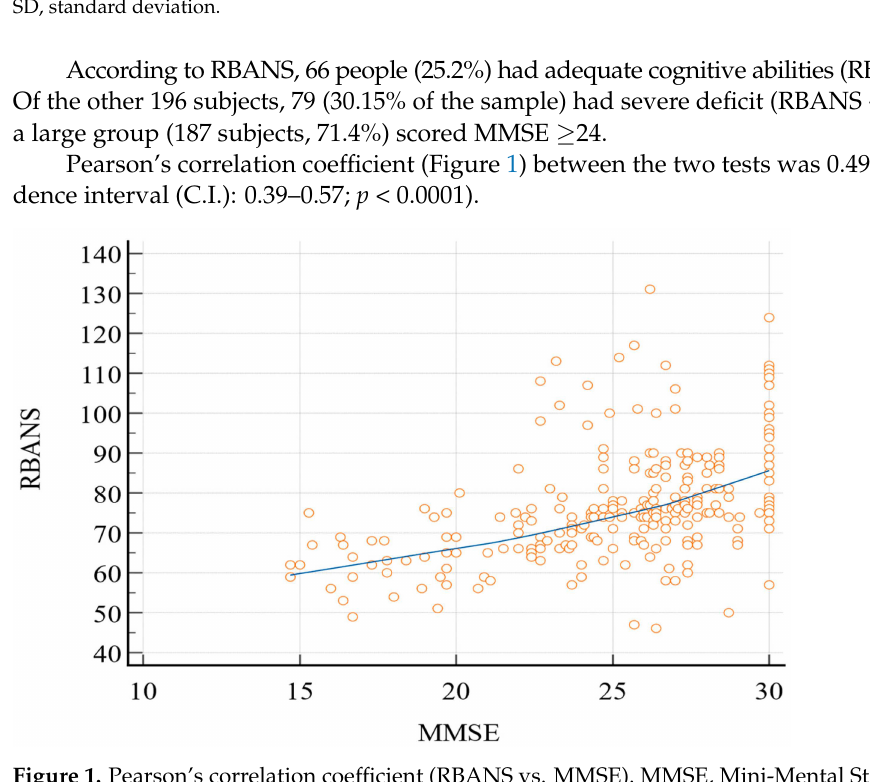
Figure 1. Pearson’s correlation coefficient (RBANS vs. MMSE). MMSE, Mini-Mental State Examina- tion; RBANS, Repeatable Battery for the Assessment of Neurocognitive